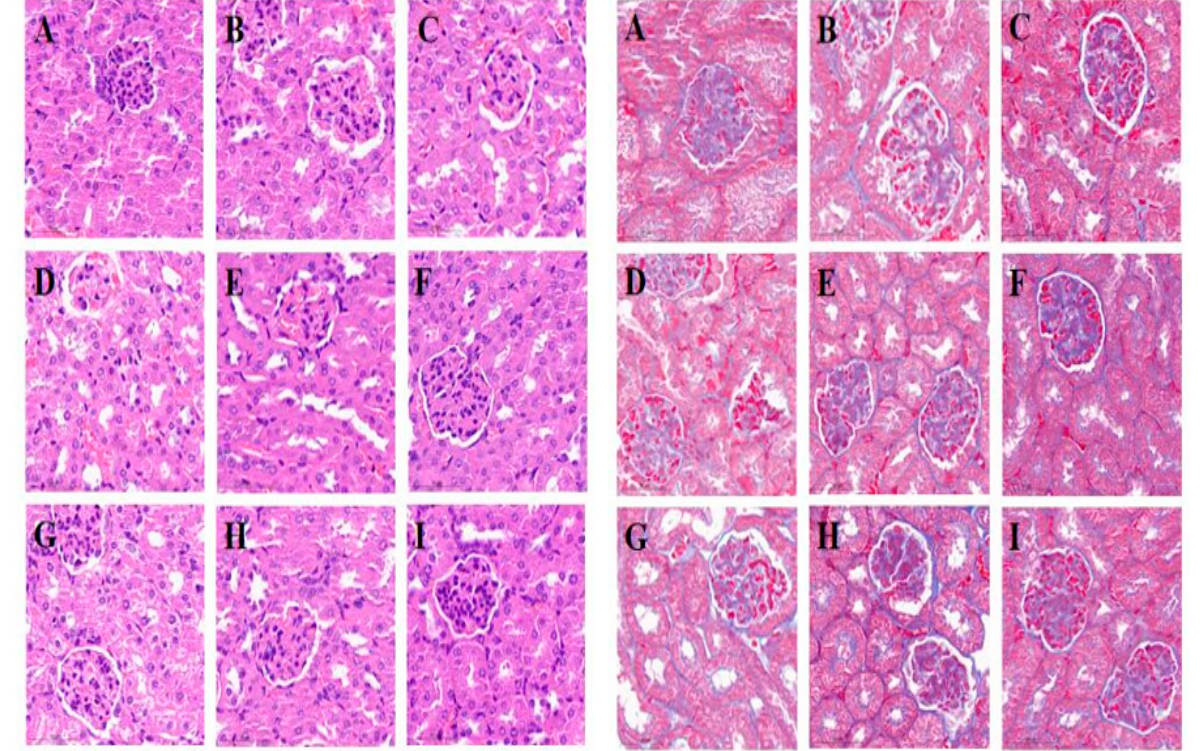
Figure 4. HE ( left ) and Masson ( right ) stained sections of mice kidneys. ( A – I ) show the kidney tissues of NC, DC, PC, GEKEL, GEKEM, GEKEH, EKEL, EKEM, and EKEH groups, respectively.